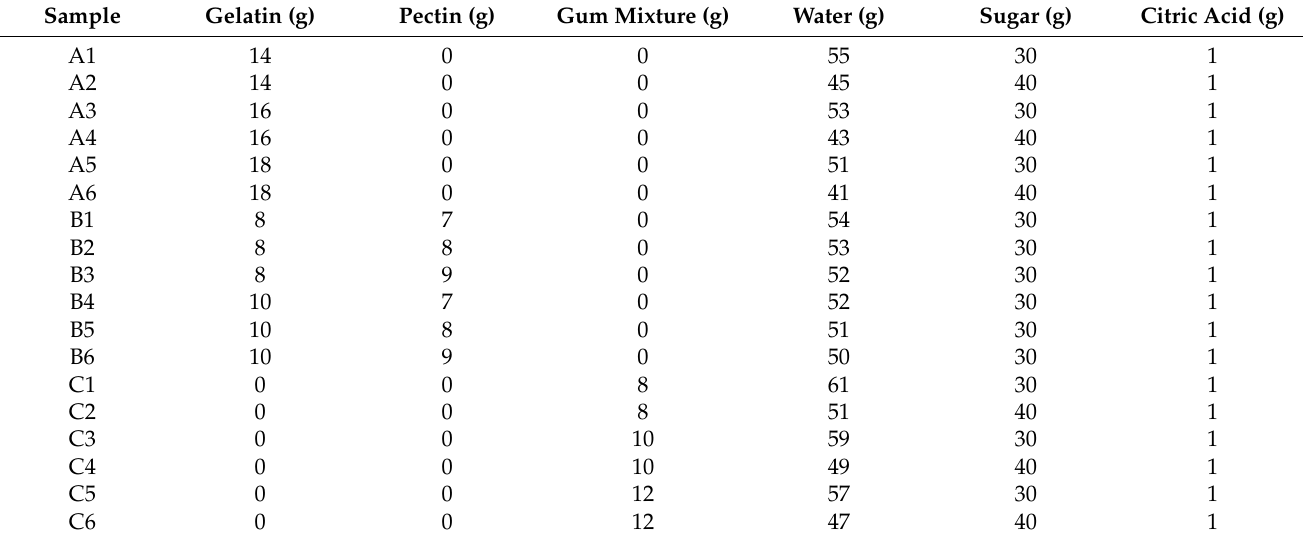
Table 1. Formulations of the samples investigated in this study.